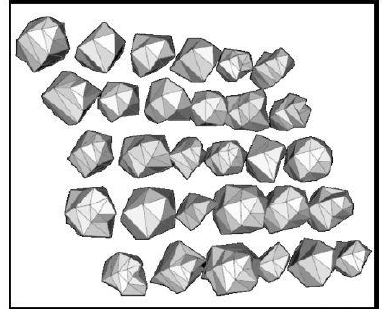
Fig. 1. Sample of randomly generated breakable grains.